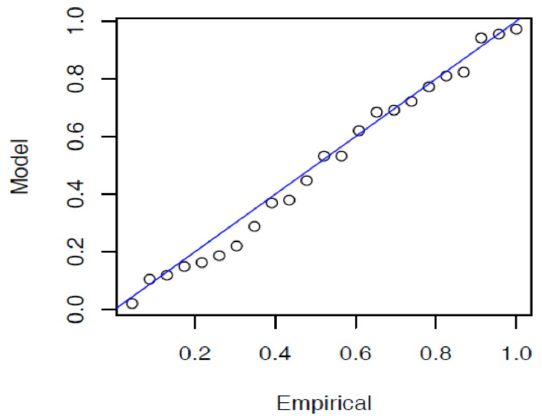
Figure 14. Comparison of the annual maxima of the quantiles of observed and simulated rainfall with a GEV model.